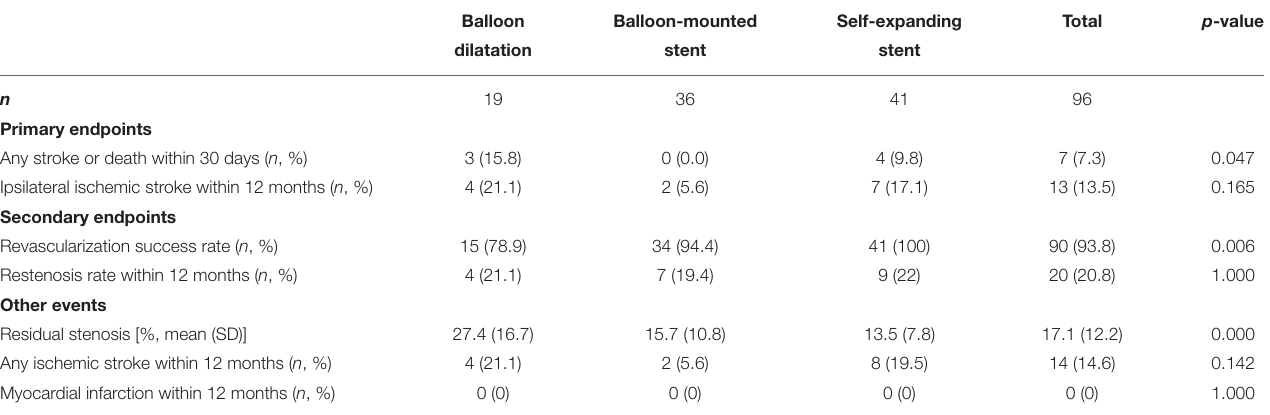
TABLE 2 | Primary and secondary endpoints and other adverse events. Balloon Balloon-mounted